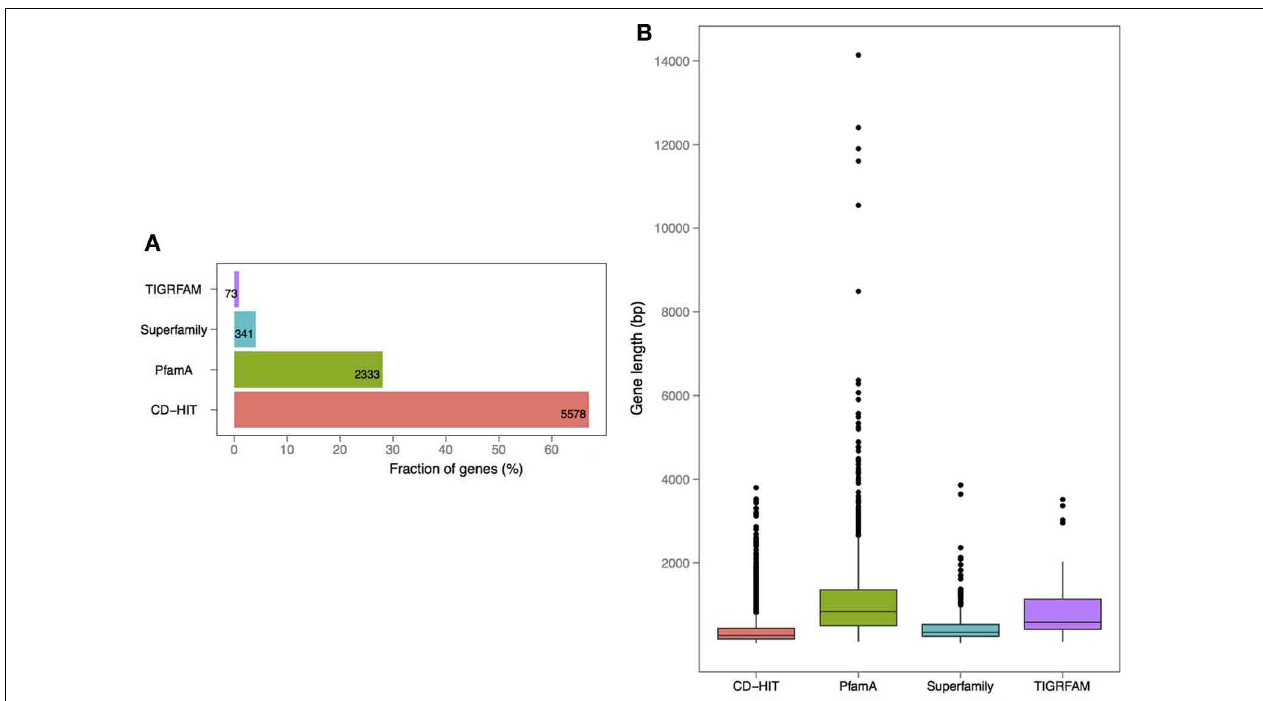
FIGURE 7 | Annotation and length distribution of proteins within specific-proteomes in draft genomes of V. cholerae (A). Distribution of profiles by assignment source: PfamA, Superfamily, TIGRFAM, and CD-HIT clustering (B) . Protein coding gene length distribution by each profile type.